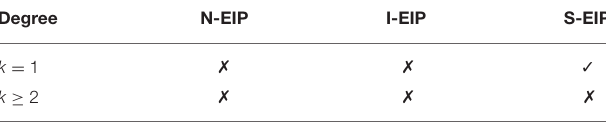
TABLE 1 | Summary of the equivalence between the EIP and CG methods for various polynomial degrees k and different values of ǫ = { 0, ± 1 } .